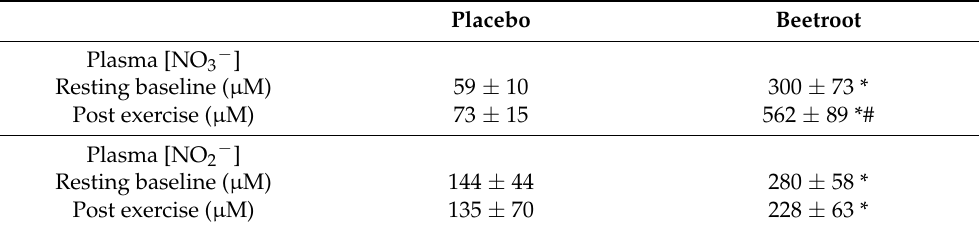
Table 1. Plasma nitrate and nitrite concentrations at rest and following 2 h moderate-intensity exercise and a 60 s maximal-intensity end-sprint after ingestion of nitrate-rich and nitrate-depleted beetroot powder. Placebo Beetroot Plasma [NO 3 − ] Resting baseline ( µ M) 59 ± 10 Post exercise ( µ M) 562 ± 89 *# Plasma [NO 2 − ] Resting baseline ( µ M) 144 ± 44 280 ± 58 * Post exercise ( µ M) 135 ± 70 228 ± 63 *